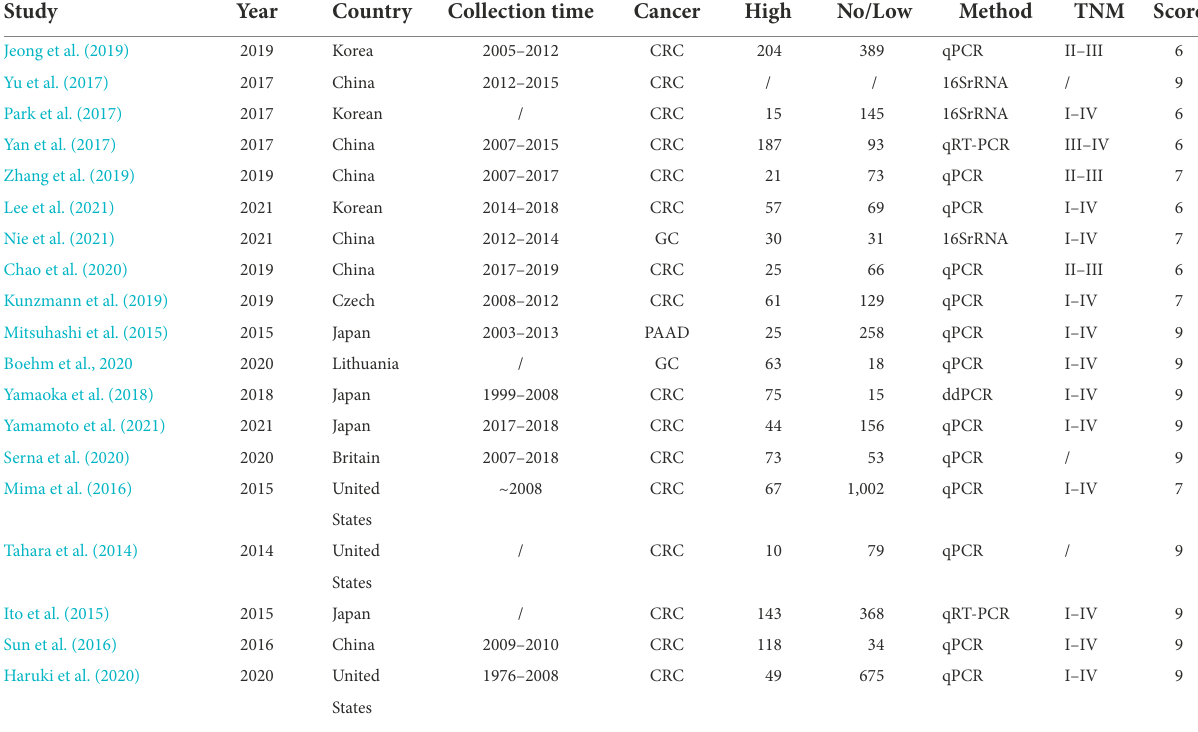
TABLE 1 Characteristics of the studies included in the